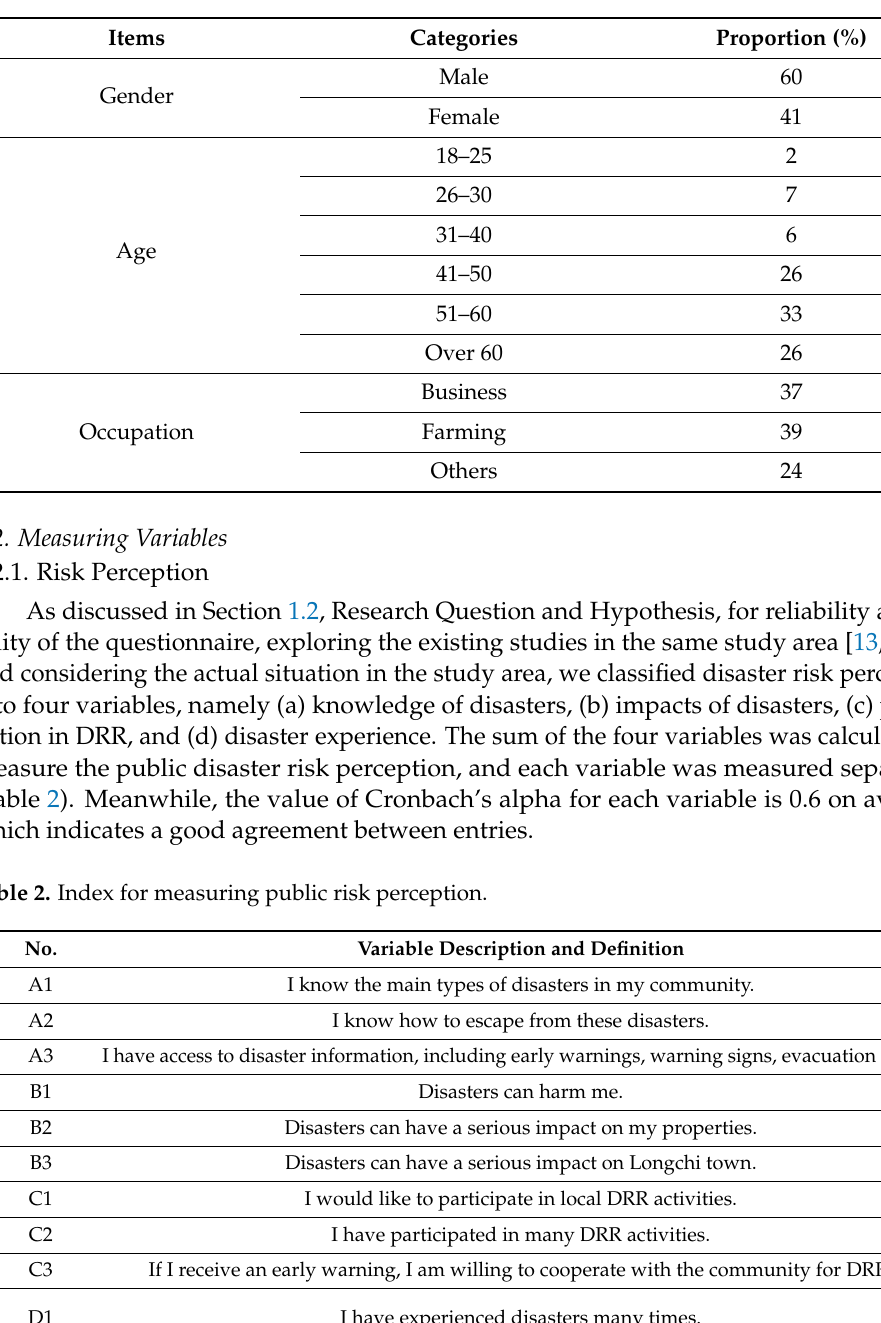
Table 1. Sample distribution.